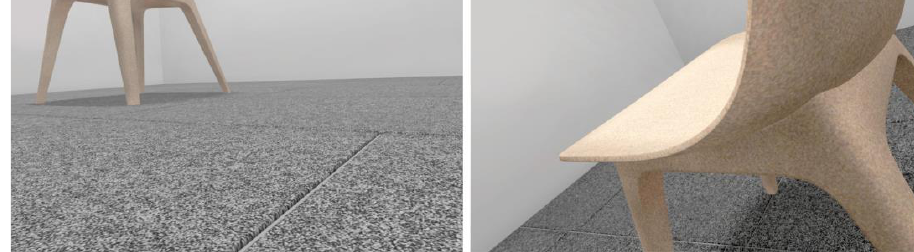
Figure 2. Chair and floor modelling, lighting and texture details (in Rooms 2 to 5).